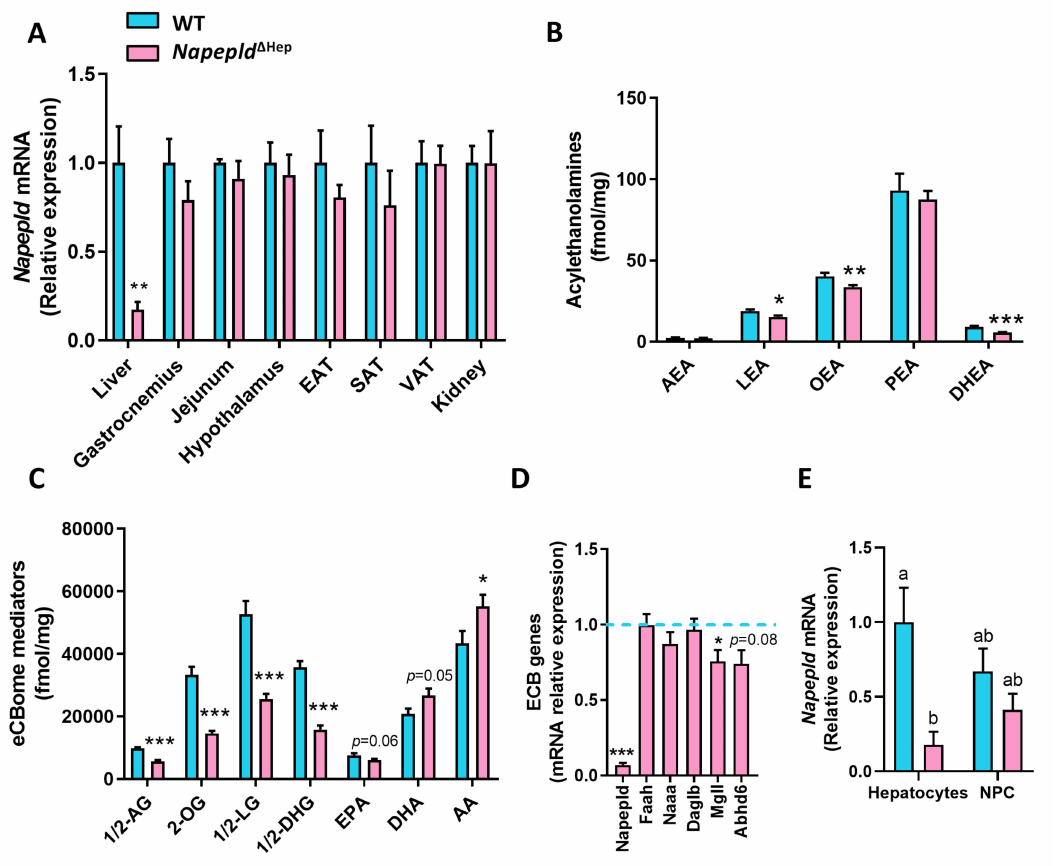
Figure 1. Hepatocyte-specific deletion of Napepld . ( A ) Napepld mRNA expression measured by real-time qPCR in the liver, gastrocnemius muscle, jejunum, hypothalamus, epididymal adipose tissue (EAT), subcutaneous adipose tissue (SAT), visceral adipose tissue (VAT) and kidney ( n = 6). ( B–C ) Levels of N -acylethanolamines and other eCBome mediators in the liver (fmol / mg; n = 8–10). ( D ) mRNA expression of key enzymes of the endocannabinoid system (ECB) measured by real-time qPCR in the liver ( n = 8–10). ( E ) Napepld mRNA expression in hepatocytes and hepatic non-parenchymal cells (NPC; n = 4–5). Blue: wild-type (WT) normal diet (ND) mice. Pink: Napepld ∆ Hep ND mice. Data are presented as the mean ± s.e.m. *, ** and *** indicate a significant di ff erence versus WT ND (Respectively p < 0.05, p < 0.01 and p < 0.001) according to the t -test. Data with di ff erent superscript letters are significantly di ff erent ( p < 0.05) according to two-way ANOVA followed by Tukey post hoc test. Lipid abbreviations: 1 / 2-AG, 1 / 2-arachidonoylglycerol; 1 / 2-DHG, 1 / 2-DHA-glycerol; 1 /